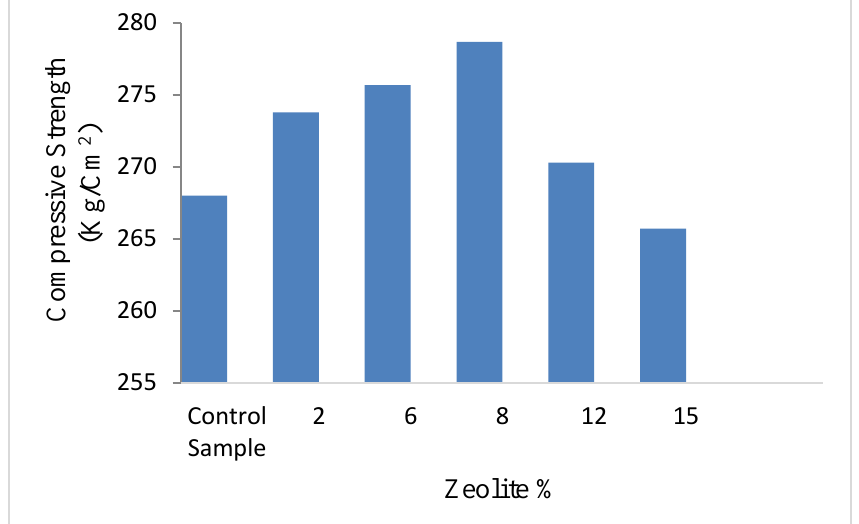
Fig. 10. Concrete strength with different percentages of Zeolite with 340 grade cement at 28 days old